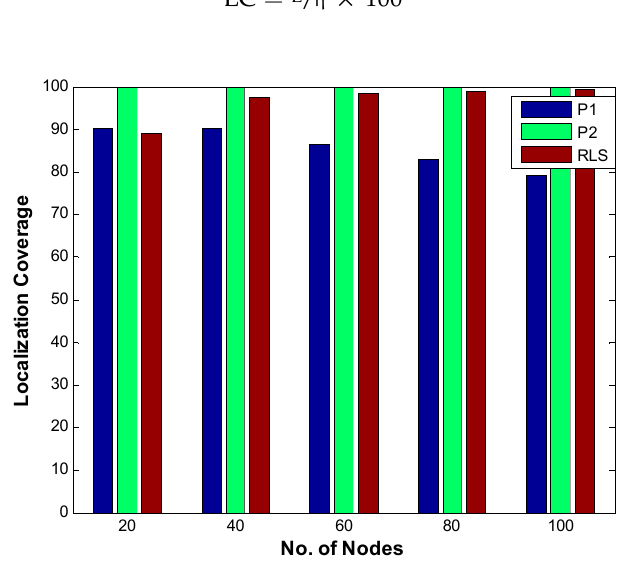
Figure 14. Localization Coverage.